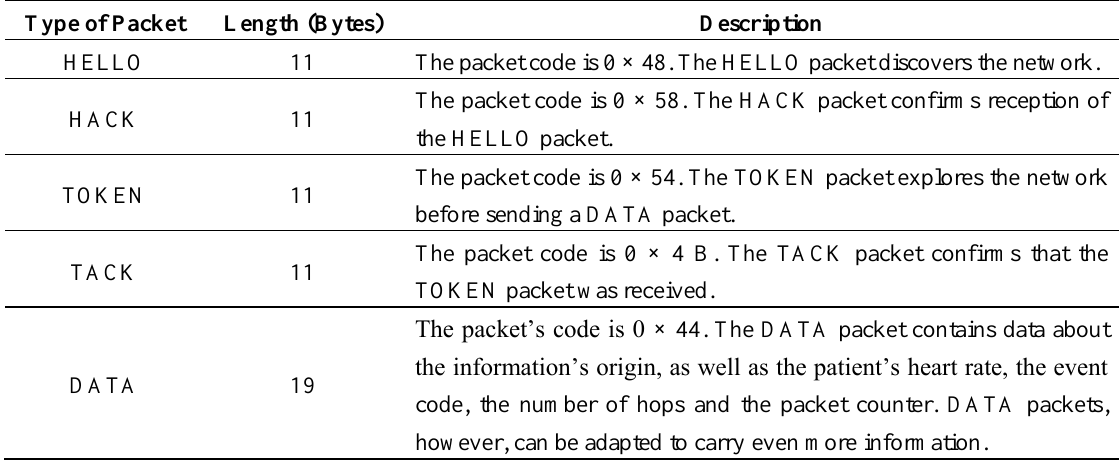
Table 2. Packets generated by the routing